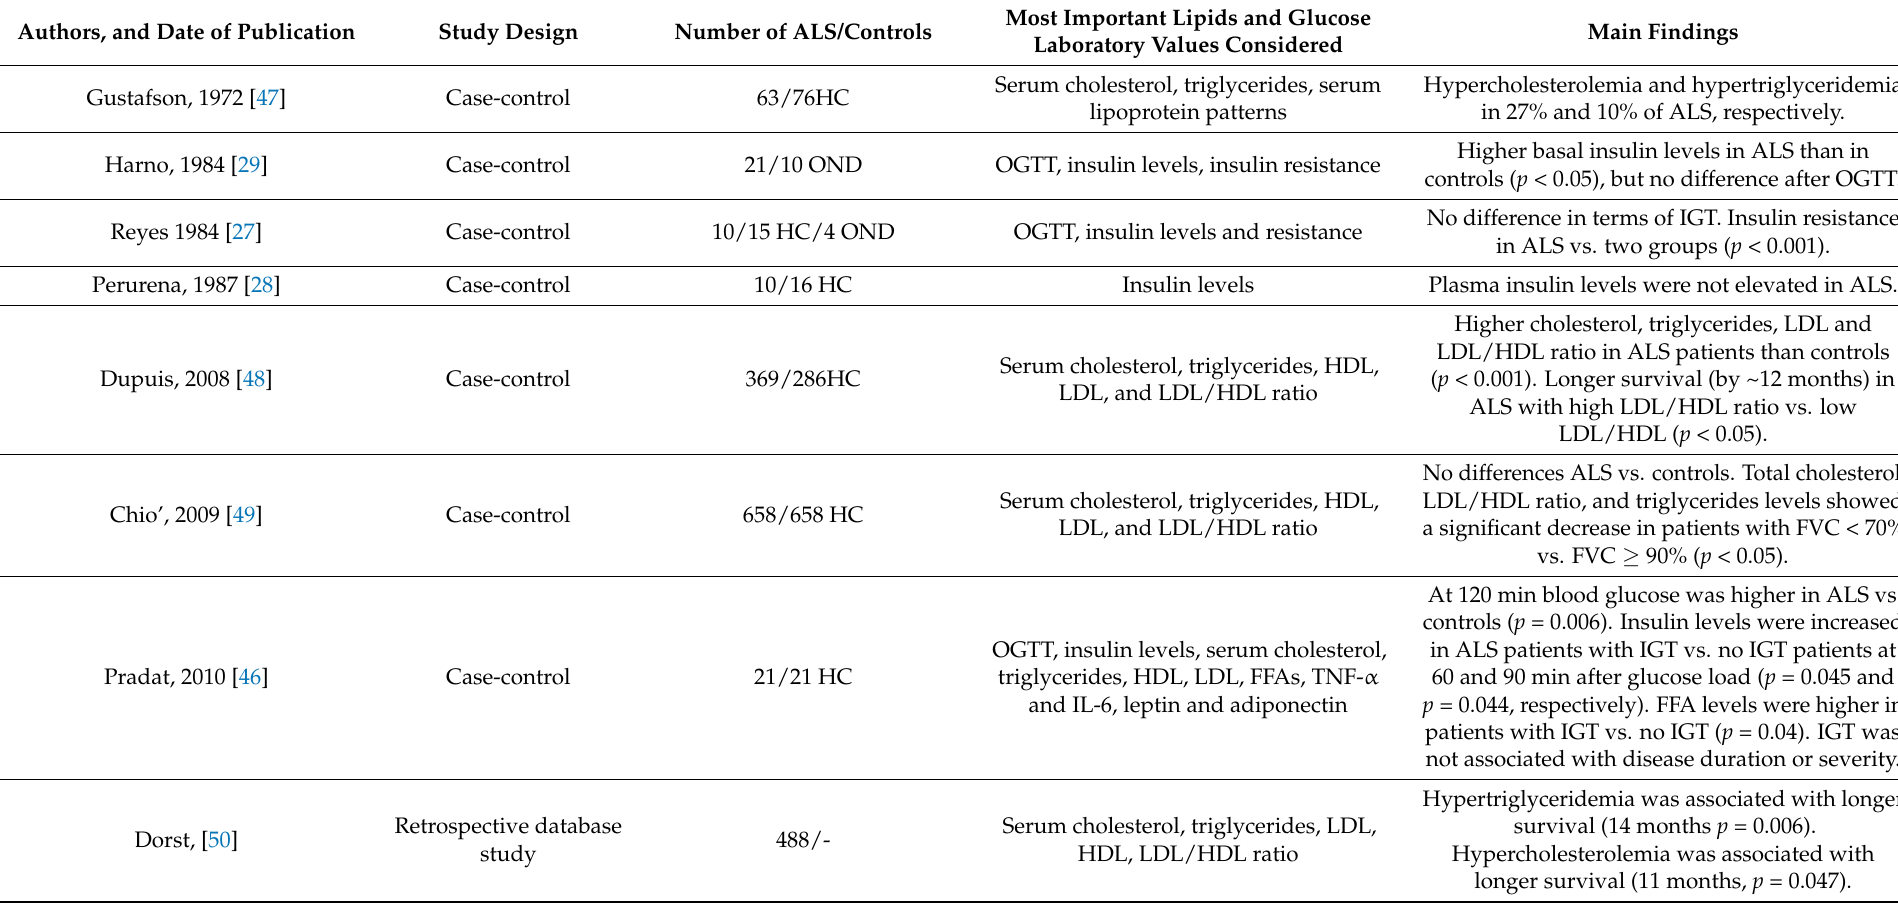
Table 1. Case series and case-control studies investigating lipid and glucose metabolism in